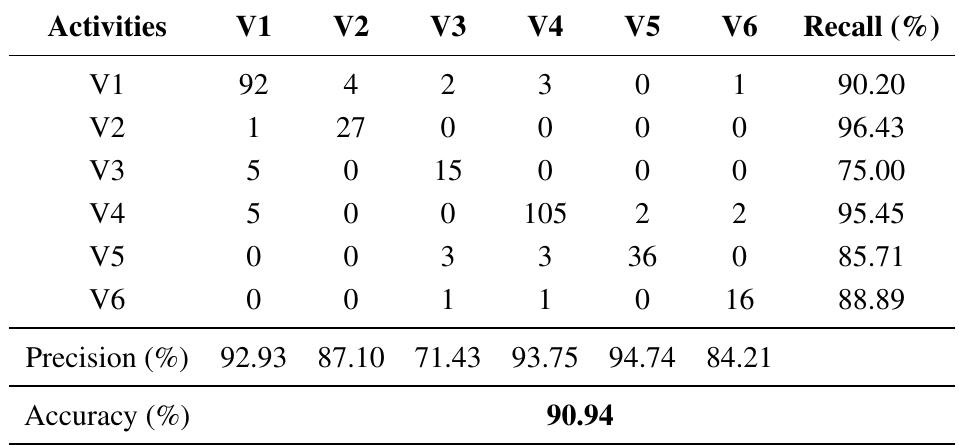
Table 5. Confusion matrix of the SVM classifier using Markov clustering topic model (MCTM) for the vertical